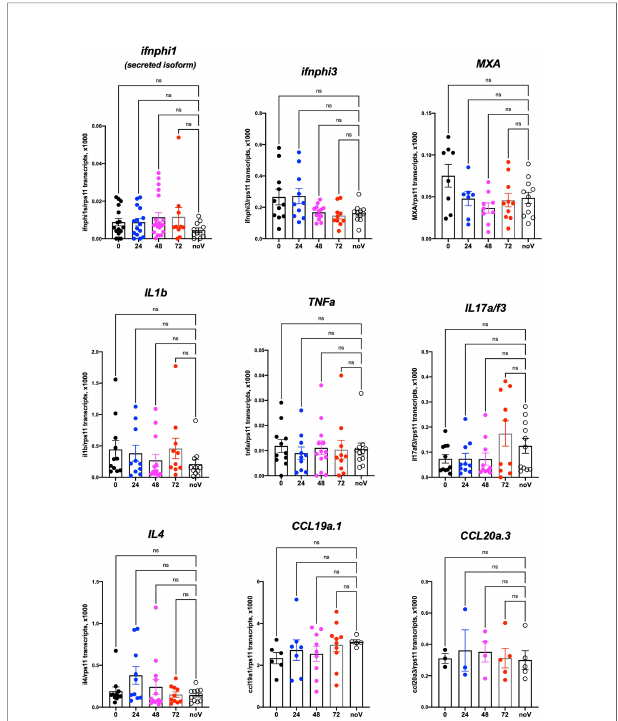
FIGURE 8 | Host response after SARS-CoV-2 injection in the swim bladder. qRT-PCR, pool of 4 independent experiments (except for ccl19a.1 and ccl20a.3, 3 and 2 experiments respectively). Numbers on the X-axis refer to hours postinjection;noV (for “ noVirus ” ):pooled uninjected negative controls, age-matched to 24, 48, or72 hpi.One-way ANOVA analysis. ns, not signi fi